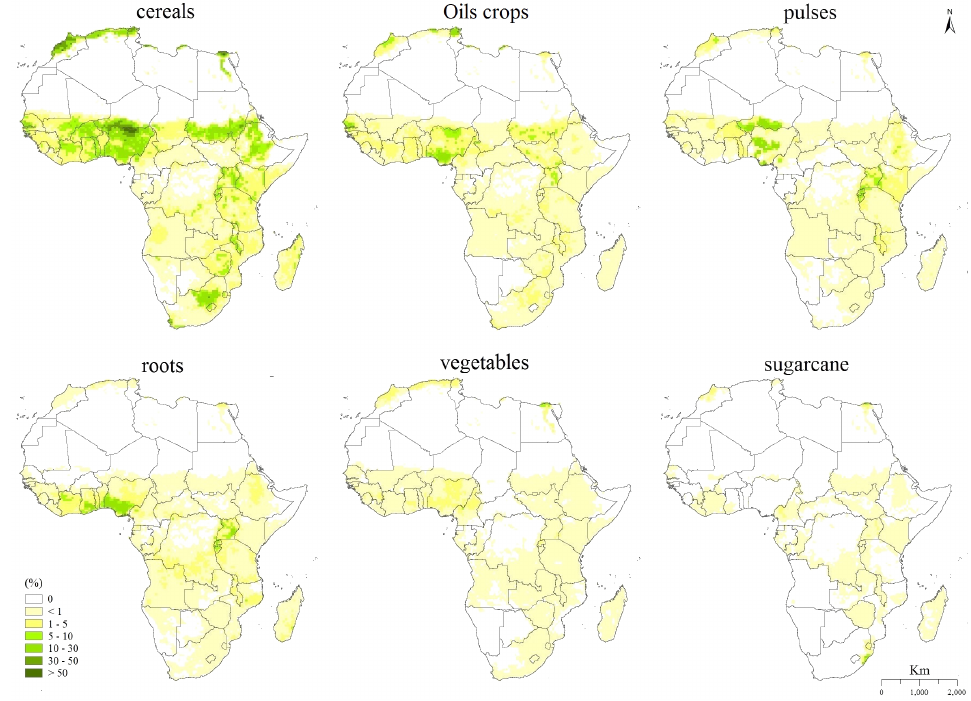
Figure 2. Proportion of crop group area per cell (0.5 ◦ × 0.5 ◦ ) cultivated in 2000 of the six largest crop groups (adapted from Ramankutty et al., 2008).